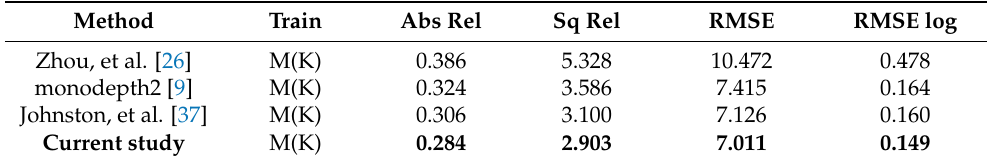
Table 2. Predicted results of our monocular depth estimation model and other current monocular depth estimation models on Make3D. M(K): a self-supervised monocular model trained on KITTI. The best results are identified in